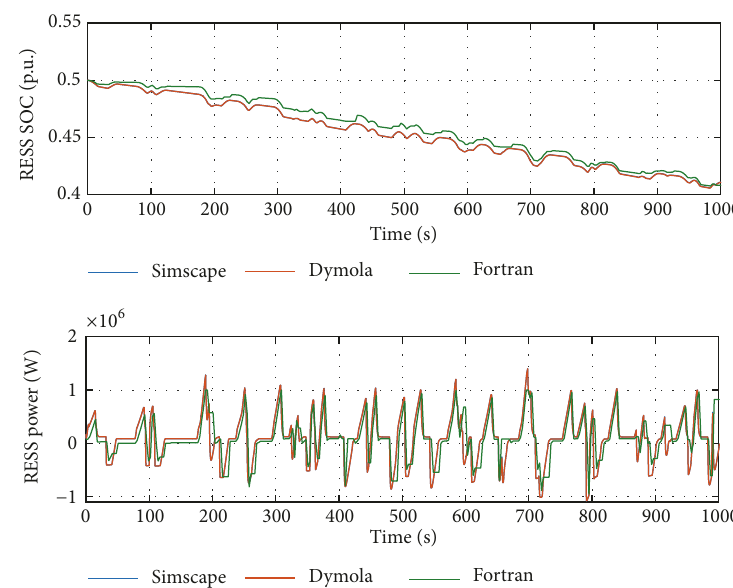
Figure 7: Plot results, system equipped with